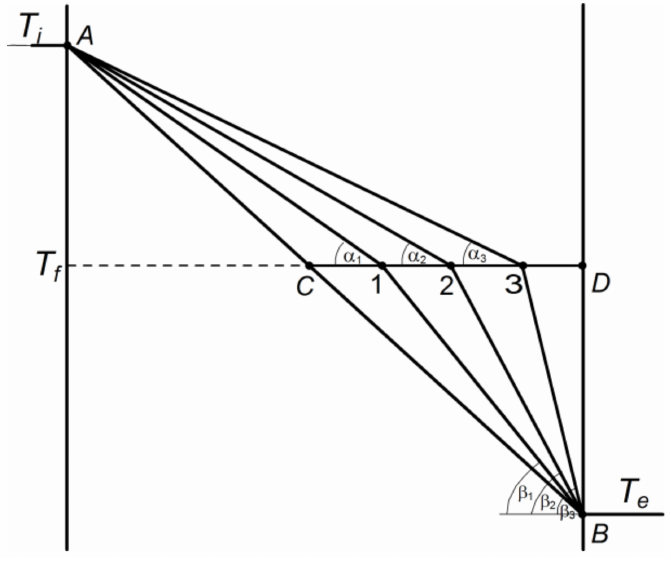
Figure 3. ATI layer